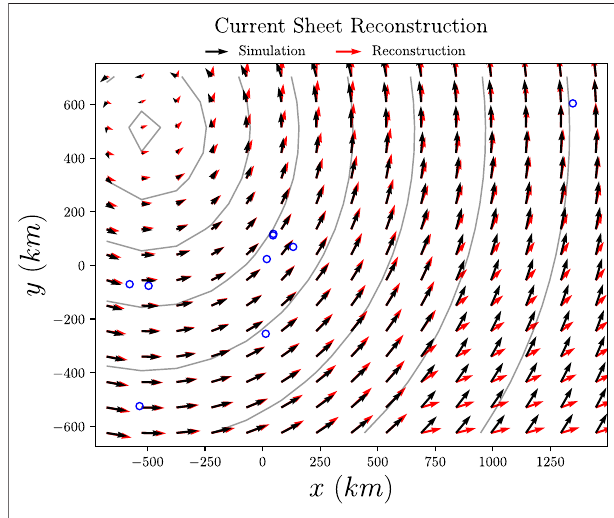
FIGURE 3 | An example of the spacecraft con fi guration at hour 94, pictured as the blue circles, reconstructing the magnetic fi eld associated with asimplecurrentsheetusing fi rst-ordermethod M 1.3 .Thetruemagnetic fi eldis shown as black arrows, and the reconstructed magnetic fi eld is shown as red arrows. This current sheet, centered at ( − 500, 500) km, has characteristic width σ (cid:1) 2000 km. Contour lines of the ^ z componentof current density J are shown in gray.